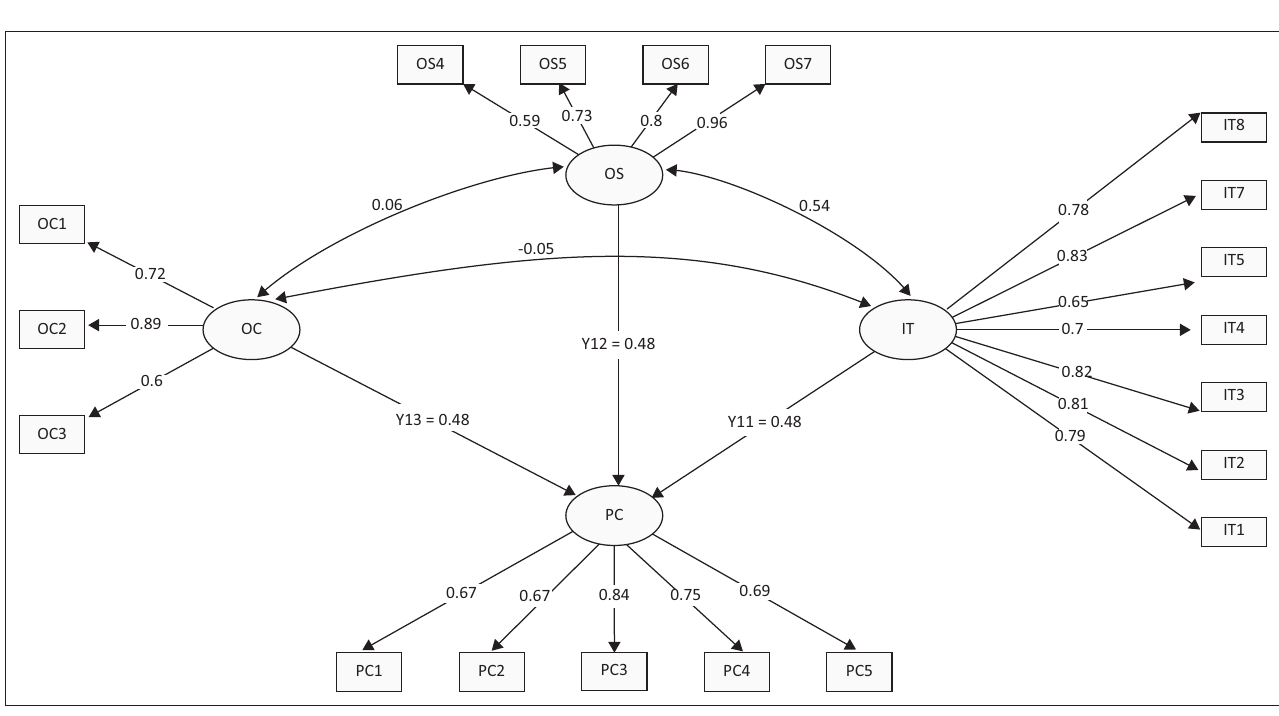
FIGURE 2 : Structural equation model.